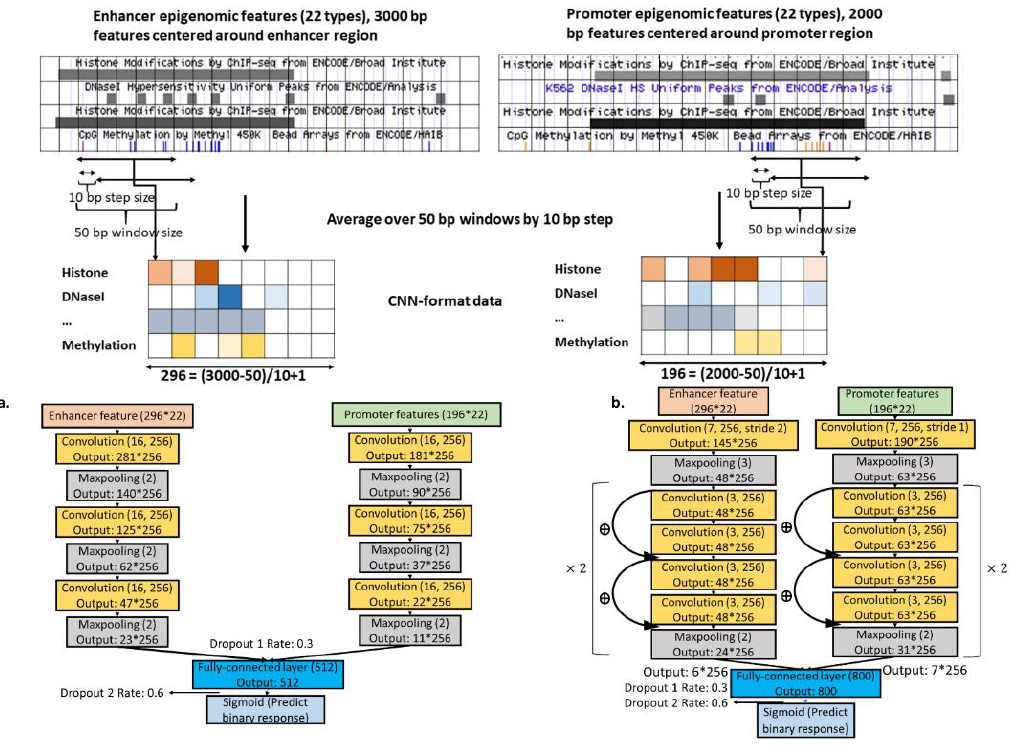
Figure 2. Epigenomics data preparation and CNN model structures. Different genomic annotation data type was denoted with different color. ( a ) Basic CNN structure; ( b ) ResNet CNN structure.